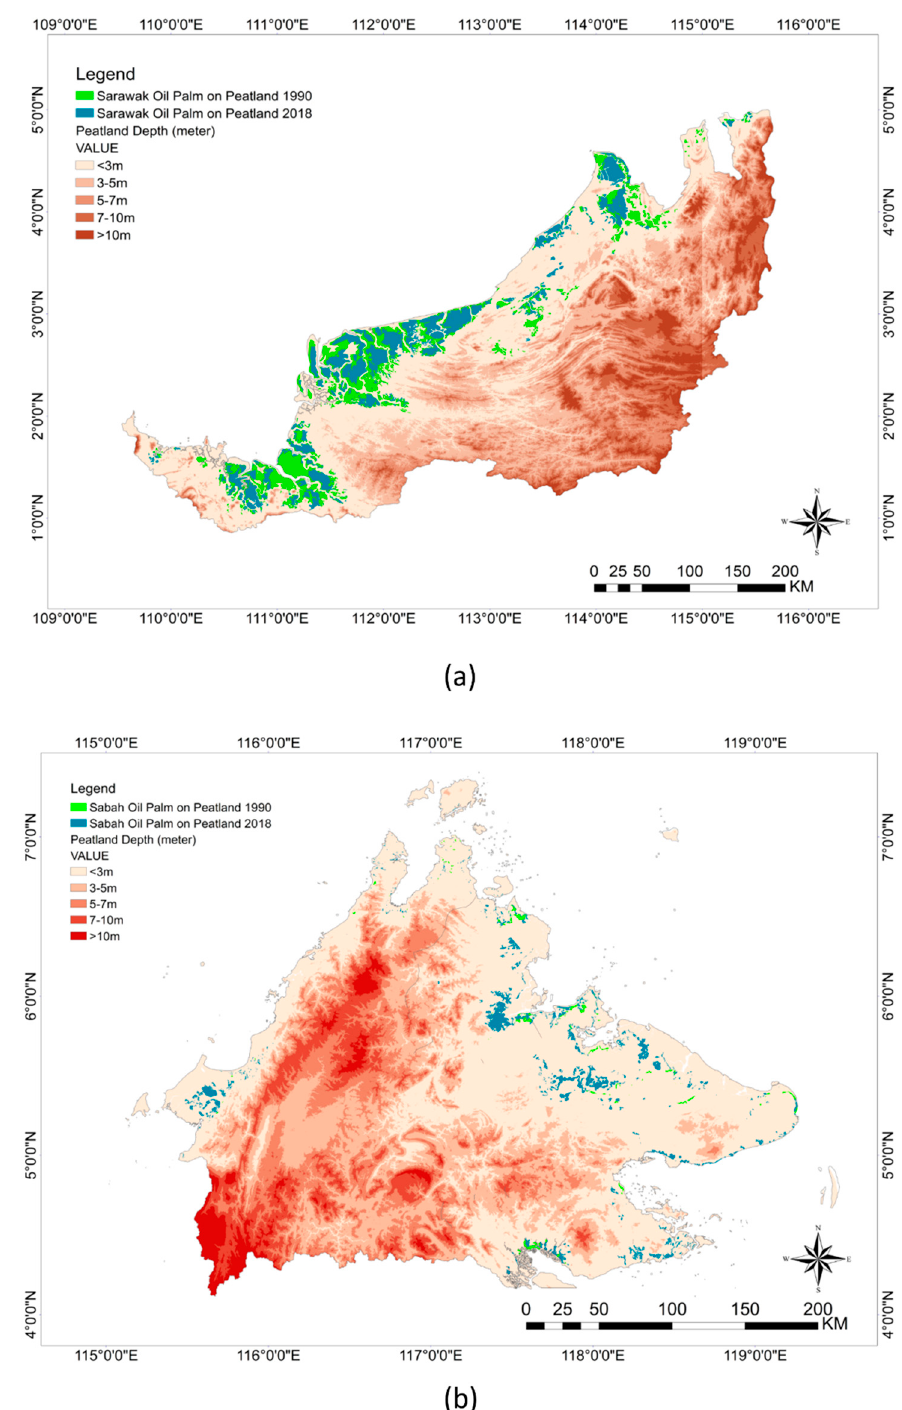
Figure 9. Oil palm development on peatlands at ( a ) Sarawak and ( b ) Sabah.